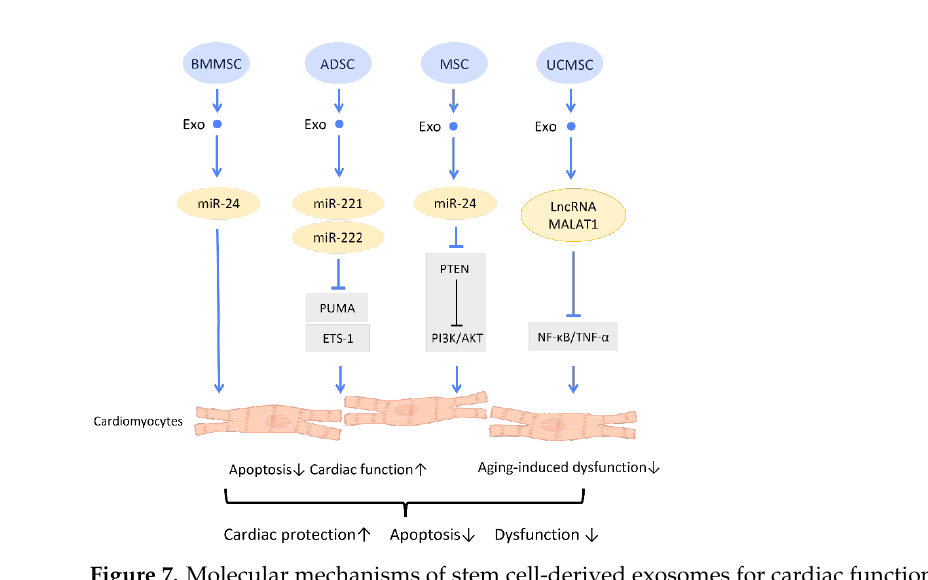
Figure 7. Molecular mechanisms of stem cell-derived exosomes for cardiac function recovery and protection. Stem cell-derived exosomes attenuate cardiac dysfunction and I/R injury through decreasing the oxidative damage and apoptosis of cardiac tissues. Abbreviation: Exo: exosome; SC: stem cell; MSC: mesenchymal stem cell; ADSC: adipose-derived stem cell; BMMSC: bone marrow-derived MSC; UCMSC: umbilical cord MSC; miR: micro-RNA; ROS: reactive oxygen species. ↑ represents upregulation; ↓ represents downregulation.